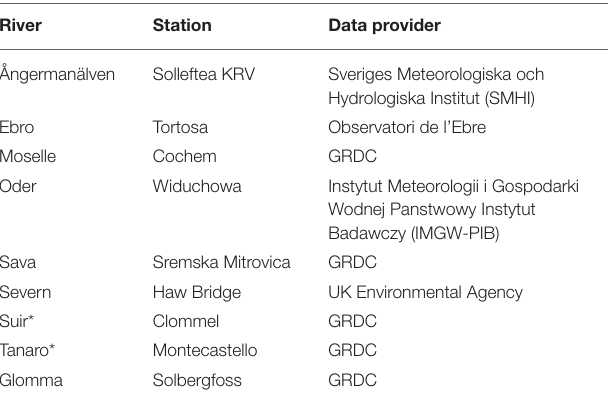
TABLE 3 | Data sources and discharge stations of the historical reference data, locations are given in Figure 1 .